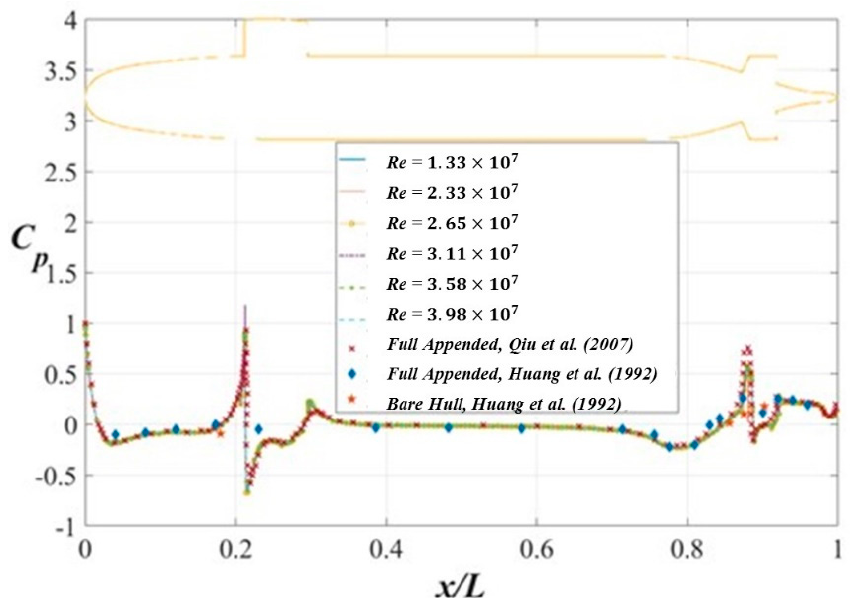
Figure 13. Comparisons of simulated and experimental pressure coe ffi cients C p along the top meridian line of the SUBOFF model under different (cid:1844)(cid:1857) conditions.